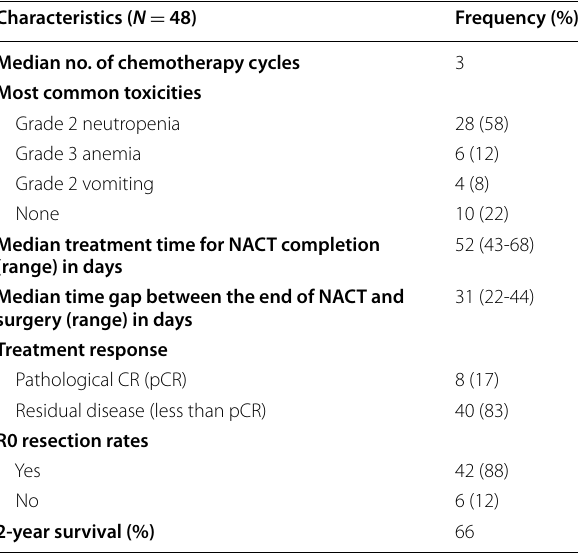
Table 3 Treatment parameters and response